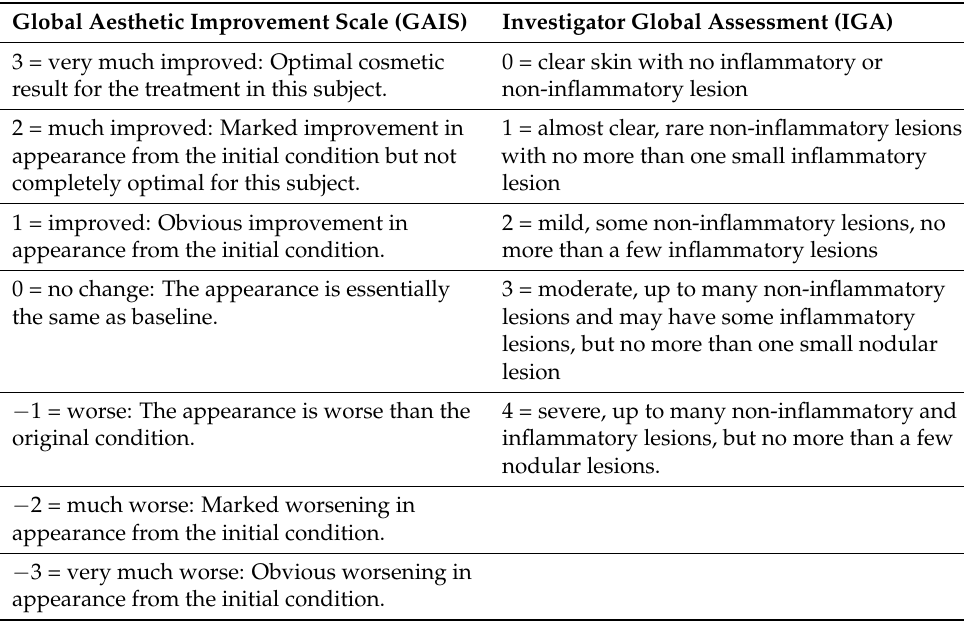
Table 1. Ratings of secondary efficacy endpoints. Global Aesthetic Improvement Scale